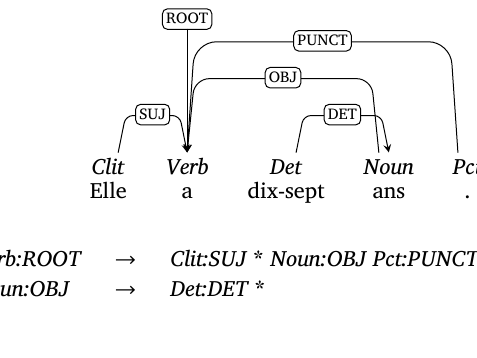
Figure 5: Property extraction